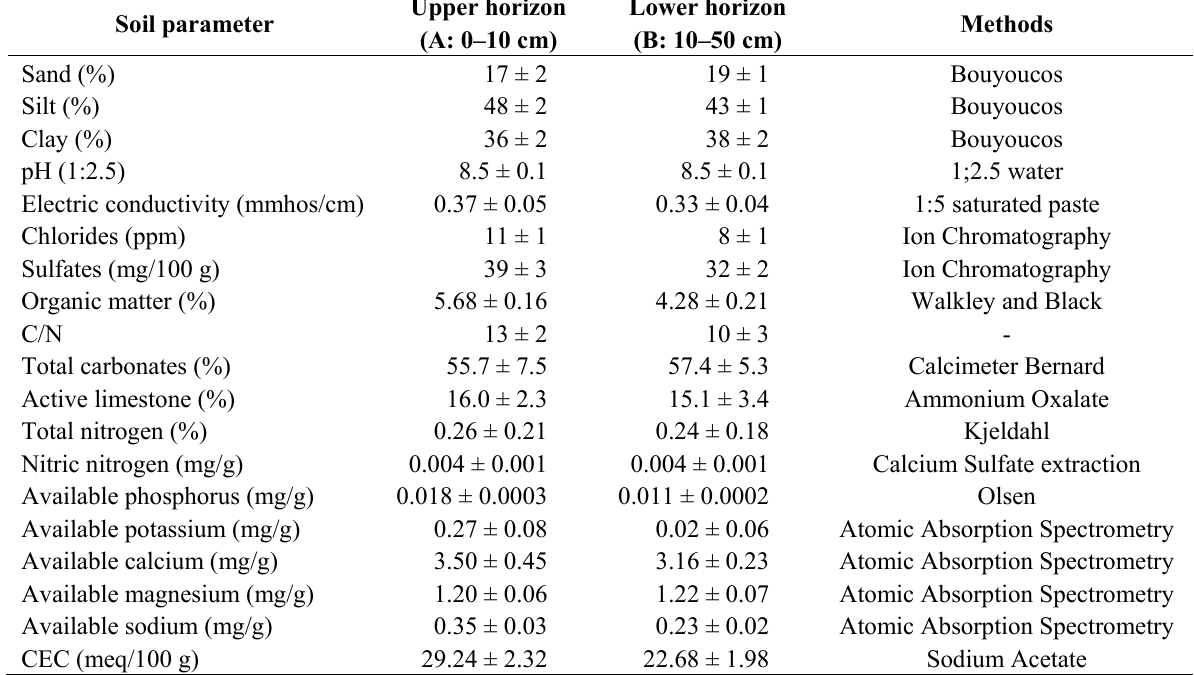
Table 1. Main soil characteristics in the study area (means ±